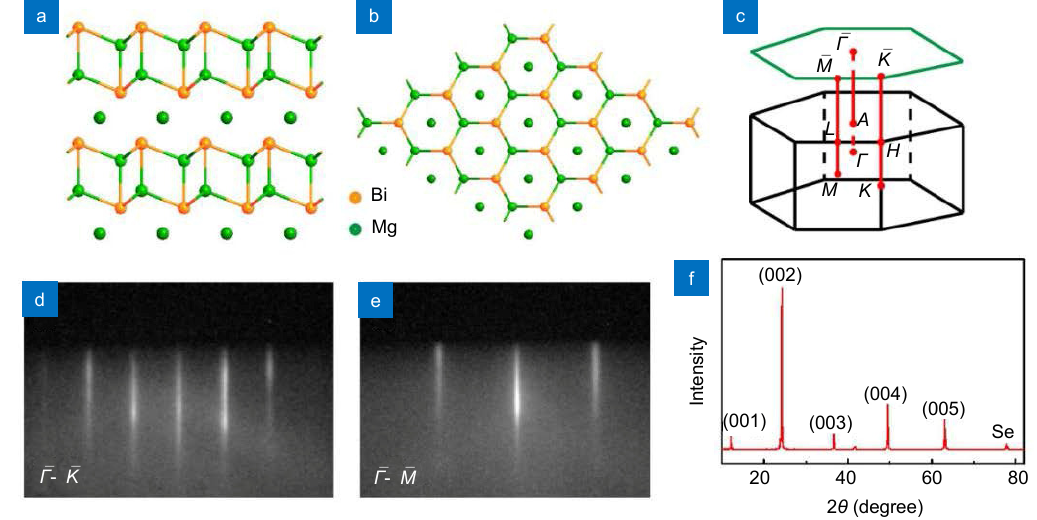
Fig. 1 | Characterization of the Mg 3 Bi 2 film. Crystal structure of Mg 3 Bi 2 from ( a ) side view and ( b ) top view. ( c ) The bulk and the projected (001) Brillouin zones of Mg 3 Bi 2 . RHEED patterns of the Mg 3 Bi 2 film grown on the sapphire substrate, with the incident electron beam along the ( d )  -  K and ( e )  -  M directions, respectively. ( f ) XRD patterns of the Mg 3 Bi 2 film, with all the (0, 0, 1n) diffraction peaks